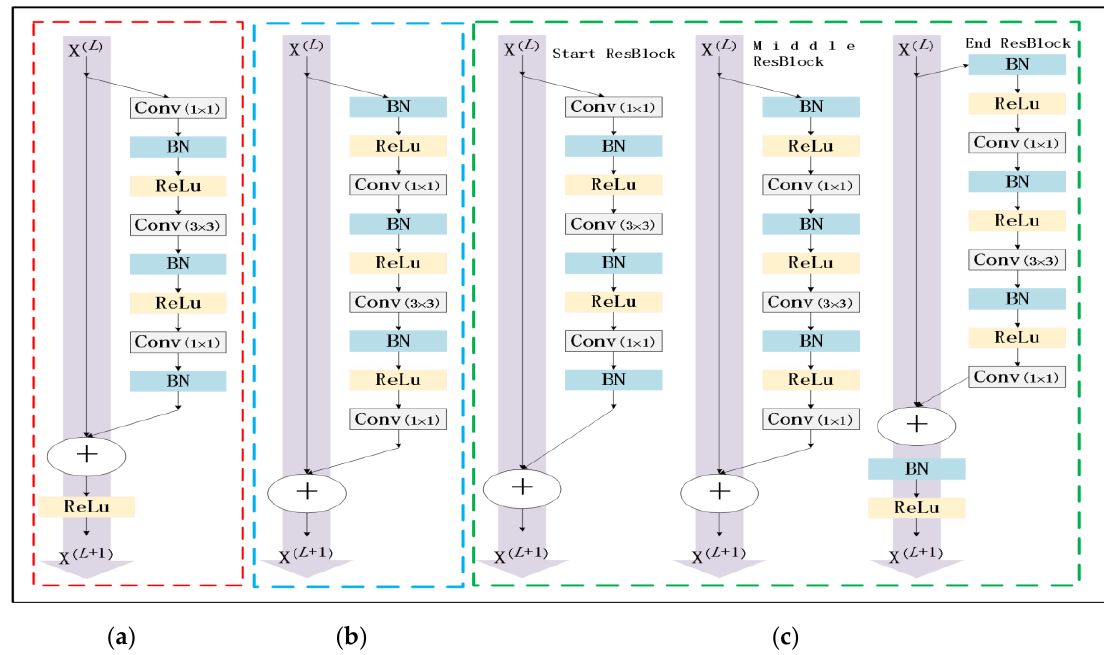
Figure 6. Comparison of ResBlock: ( a ) original (inside the red frame); ( b ) pre-activation (inside the blue frame); ( c ) the improved ResStage (inside the green frame).